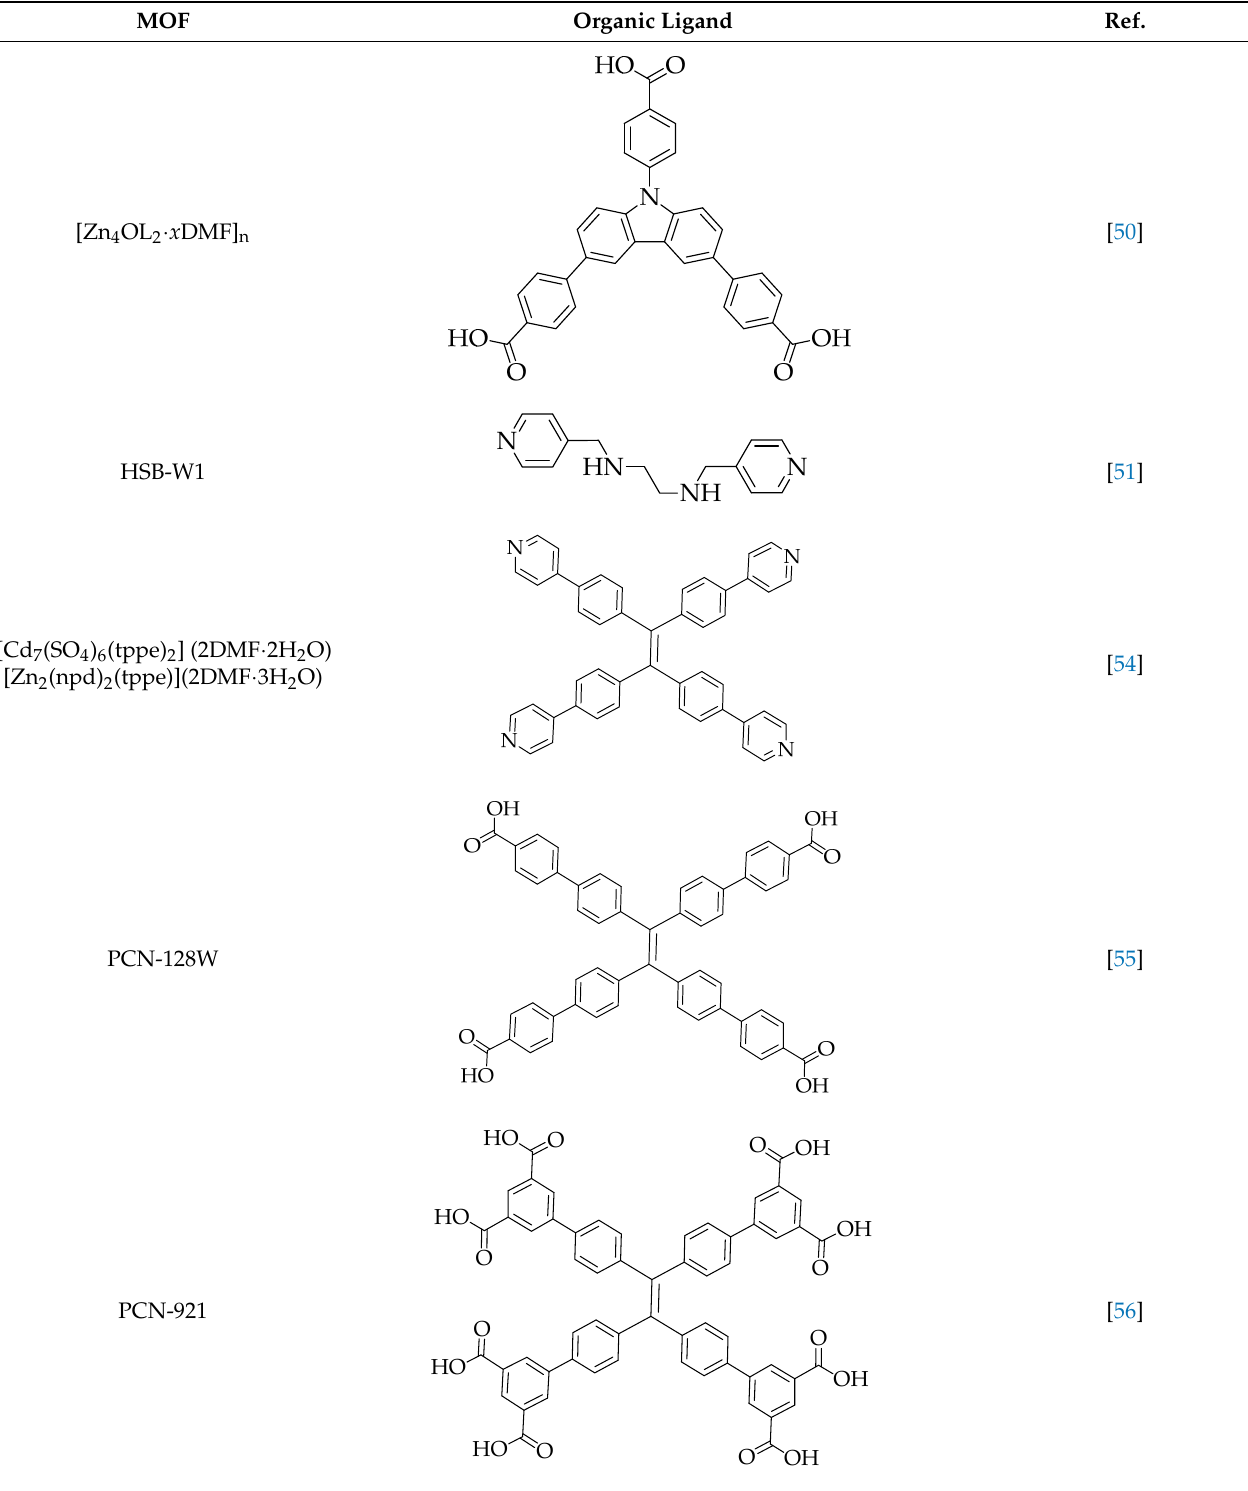
Table 1. Cont. Organic Ligand Ref.